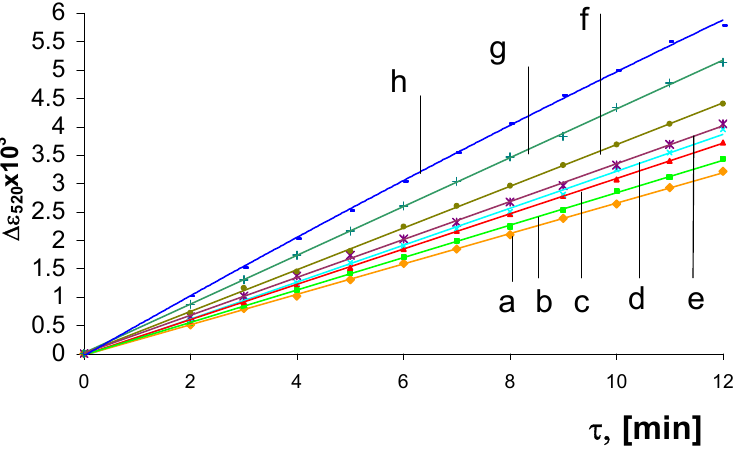
FIGURE 2 . Kinetics of urea decomposition with free urease and immobilized indicator. Concentration in mM: (a) 2; (b) 5; (c) 10; (d) 30; (e) 50; (f) 100; (g) 300; (h)